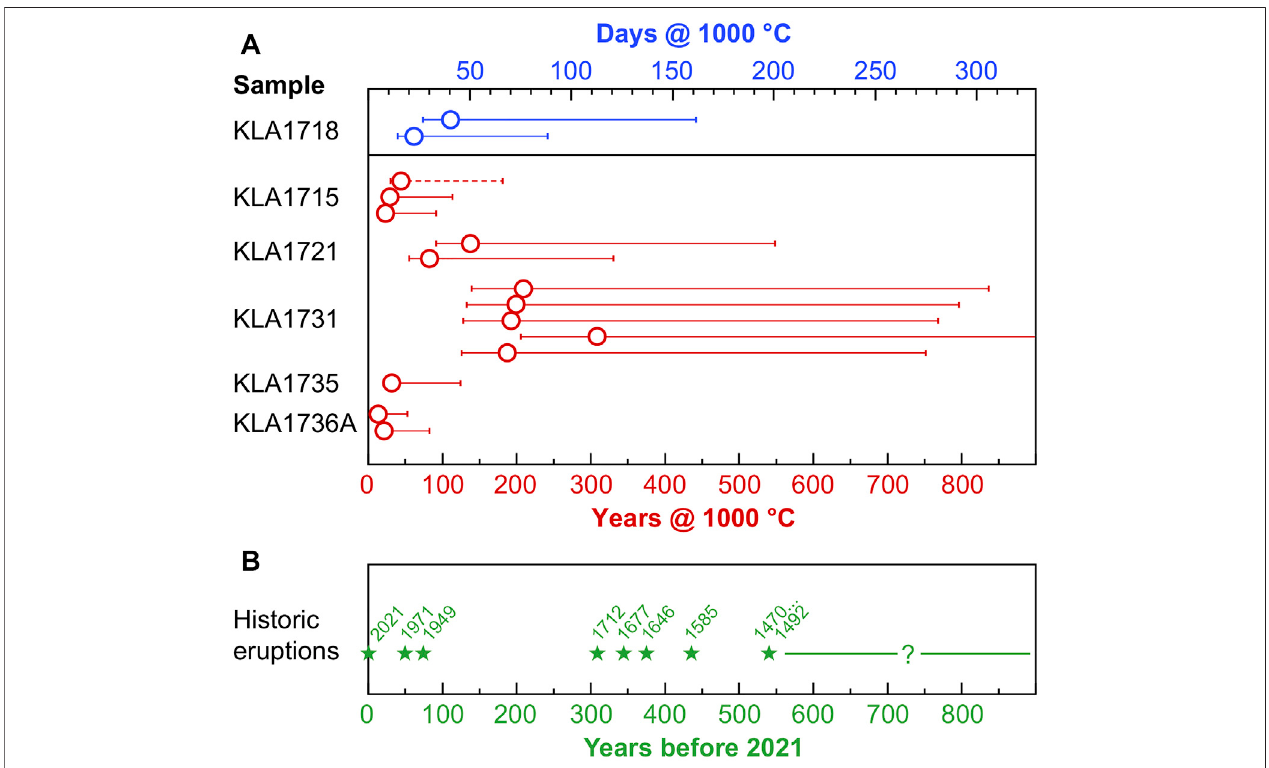
FIGURE9|(A) Rangeofdiffusiontimes forrim zonationsofthetephriphonolite-hosted peridotitexenoliths,based onasimpleFe-Mginterdiffusionmodel inolivine ( see text for details). Note different scales for sample KLA1718 (blue, top) and the other samples (red, bottom). The large time range for each sample re fl ects the anisotropyofD FeMg byafactorofsix;circlesmarkthediffusiontimeforthemeanD FeMg ofrandomlyorientatedolivinegrains(equalto2/3theD FeMg along[001]).Diffusion times were calculated for a temperature of 1,000 ° C; a temperature increase or decrease by 50 ° C would roughly double or halve the calculated times. (B) The diffusiontimesarecomparedtoatimelineforhistoriceruptionsonCumbreVieja,applyingthesamescaleasin (A) .TheeruptionagesaresummarizedinCarracedoetal. (2001).